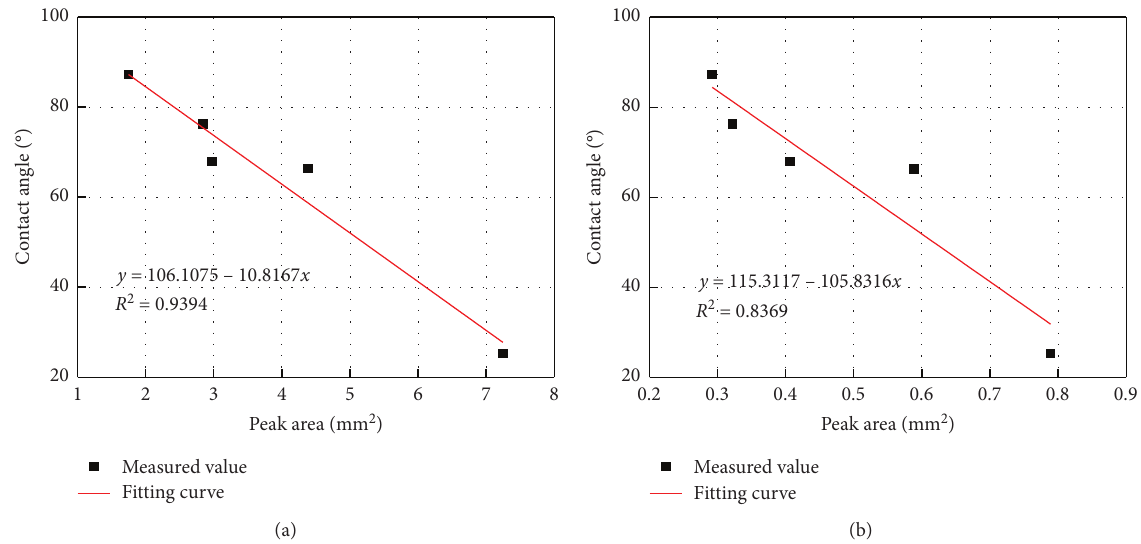
Figure 10: Relationship between the measured contact angle and the areas of the characteristic peaks: (a) 1600–1620cm − 1 ; (b) 1020–1110cm − 1 .